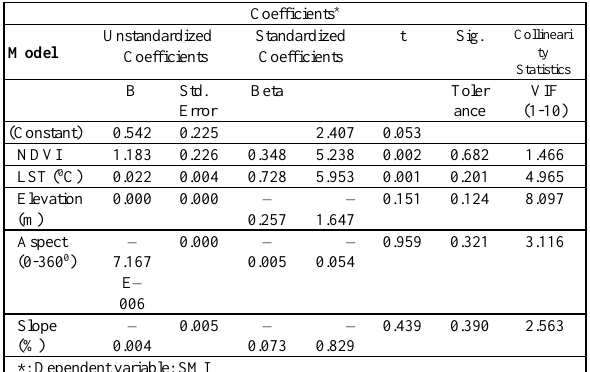
*: Dependent variable: SMI Table 2. Result of regression analysis From the assumption (Equation (6)), we developed the model